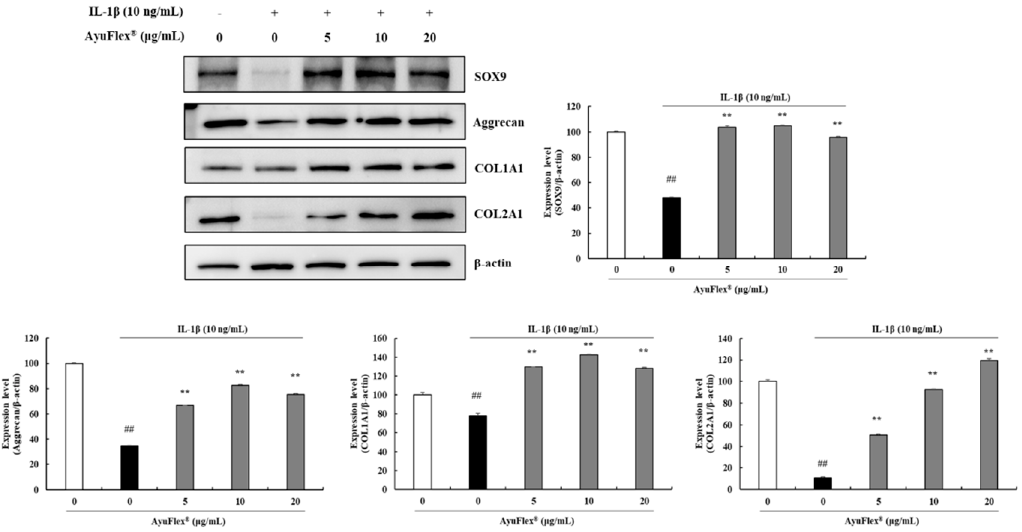
Figure 4. AyuFlex ® treatment attenuated the degradation of collagen synthesis-involved proteins in IL-1 β -treated HCHs. HCHs were exposed with IL-1 β (10 ng / mL) single or in combination with AyuFlex ® (5, 10, and 20 µ g / mL) for 24 h. The expression of SOX9 (65 kDa), aggrecan (110 kDa), COL1A1 (220 kDa), and COL2A1 (190 kDa) was determined by western blotting. Protein bands were quantified utilizing ImageJ. As the control for normalization, β -actin was utilized. ## p < 0.01, in comparison with the vehicle control group. ** p < 0.01, in comparison with the IL-1 β -treated control group.